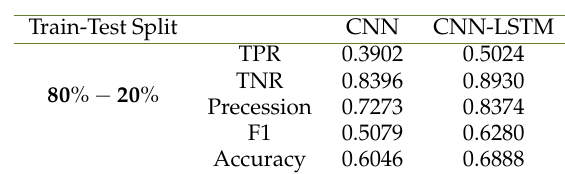
Table 6. Result of ablation test on the Youtube data